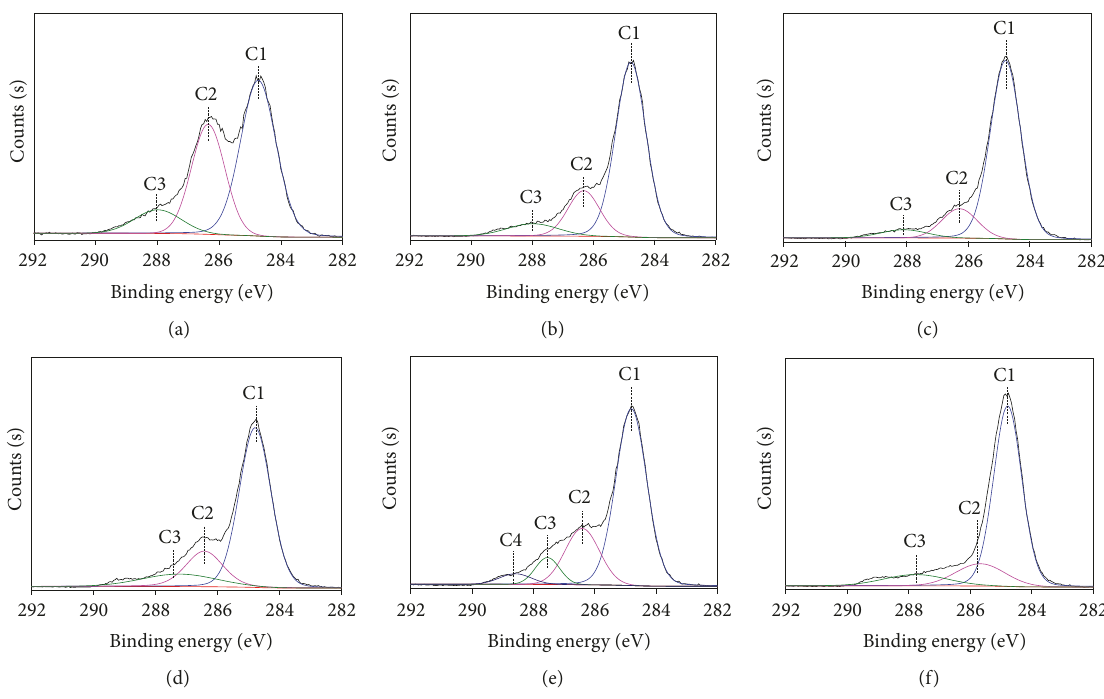
Figure 5: C 1 s peak spectra of bamboo, BS, HBS, and their coated samples. (a) Bamboo; (b) BS; (c) HBS; (d) PUA coated bamboo; (e) PUA coated BS; (f) PUA coated HBS.